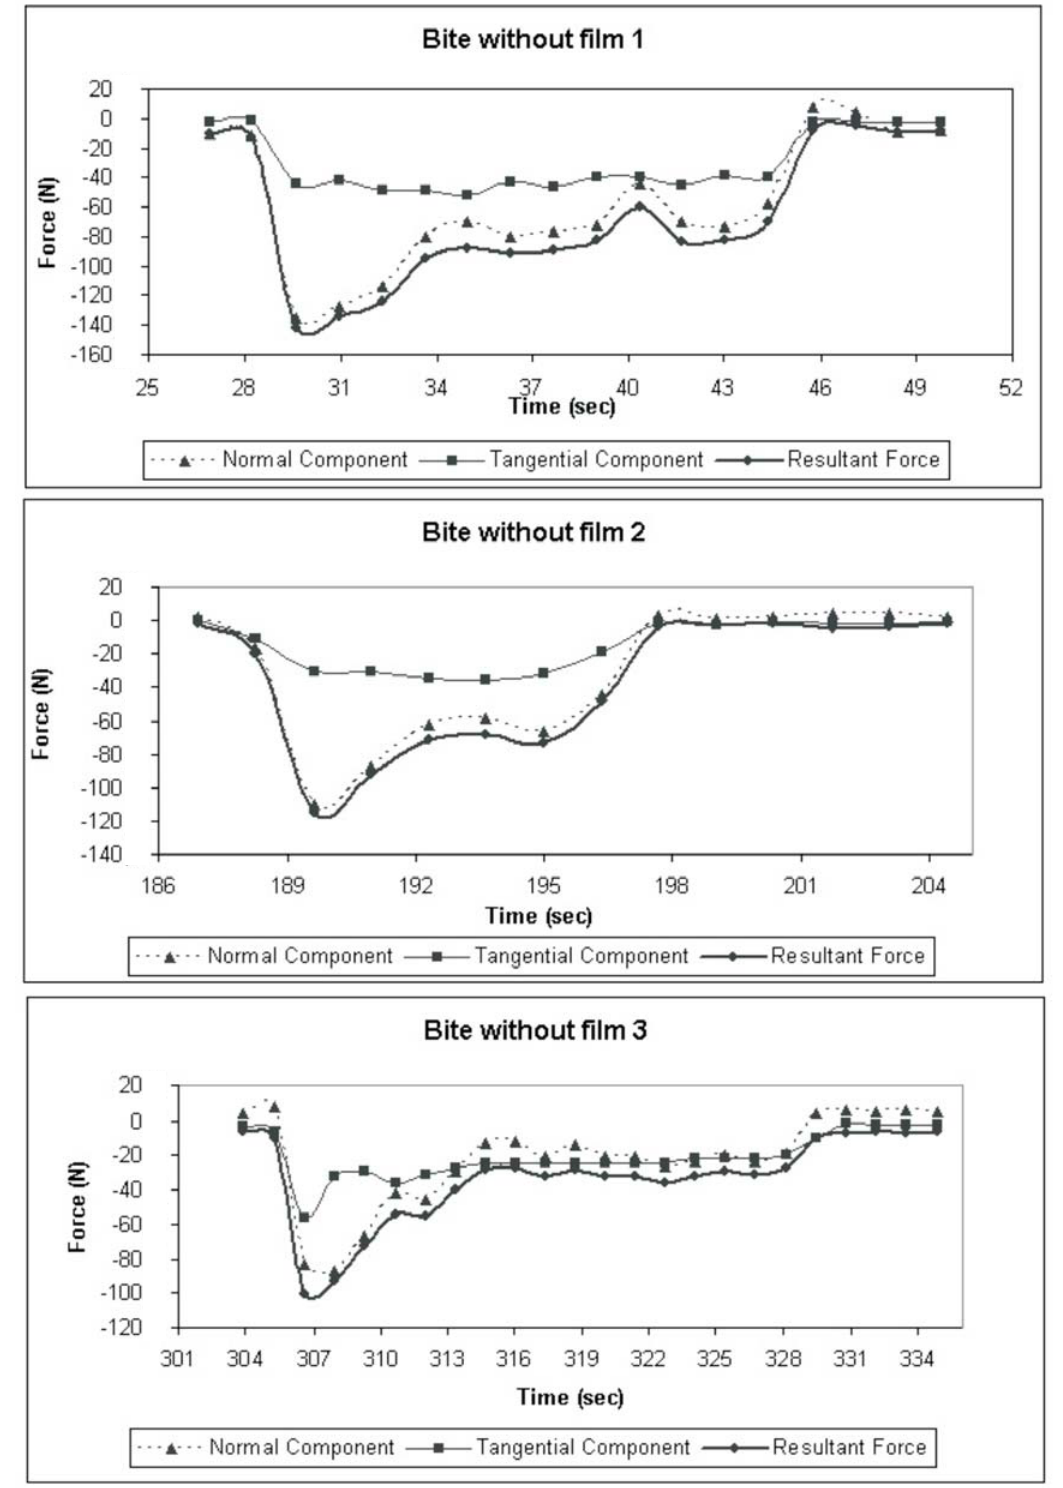
FIGURE 3- Results for occlusion assays without